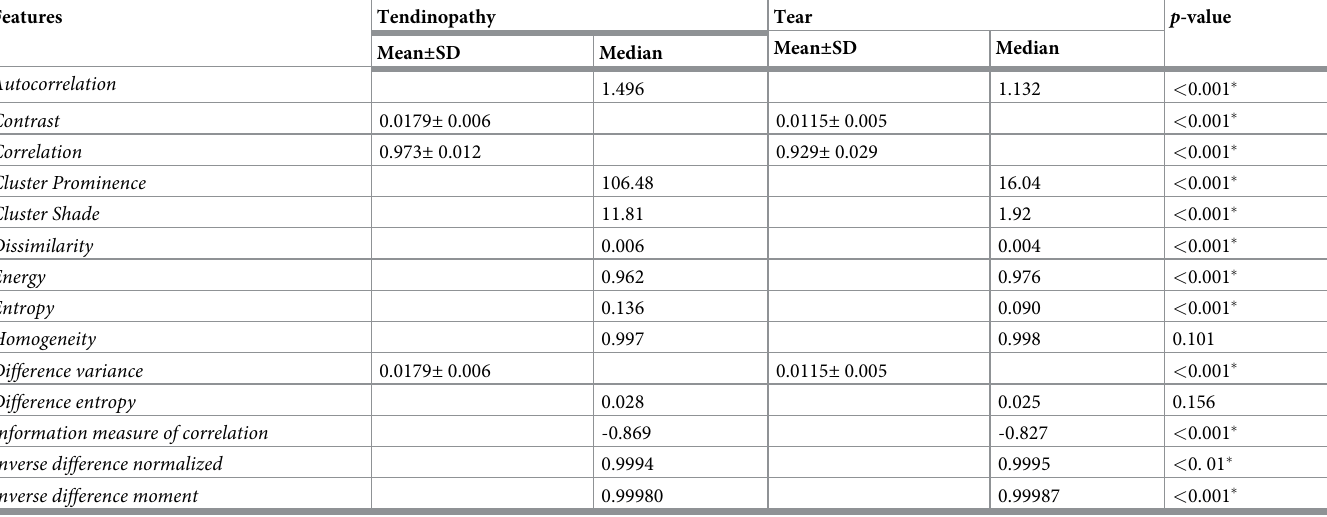
Table 2. The test results of texture features using student’s t -test (mean) or the Mann-Whitney U-test (median).